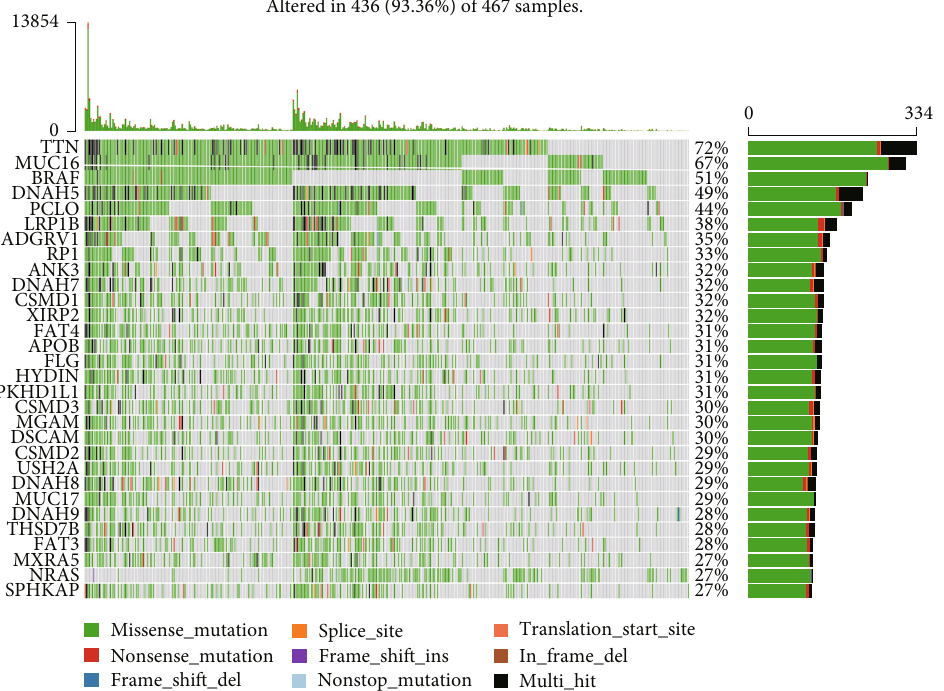
Figure 1: Landscape of mutation pro fi les in SKCM samples. Mutation information of each gene in each sample was shown in the waterfall plot, in which various colors with annotations at the bottom represented the di ff erent mutation